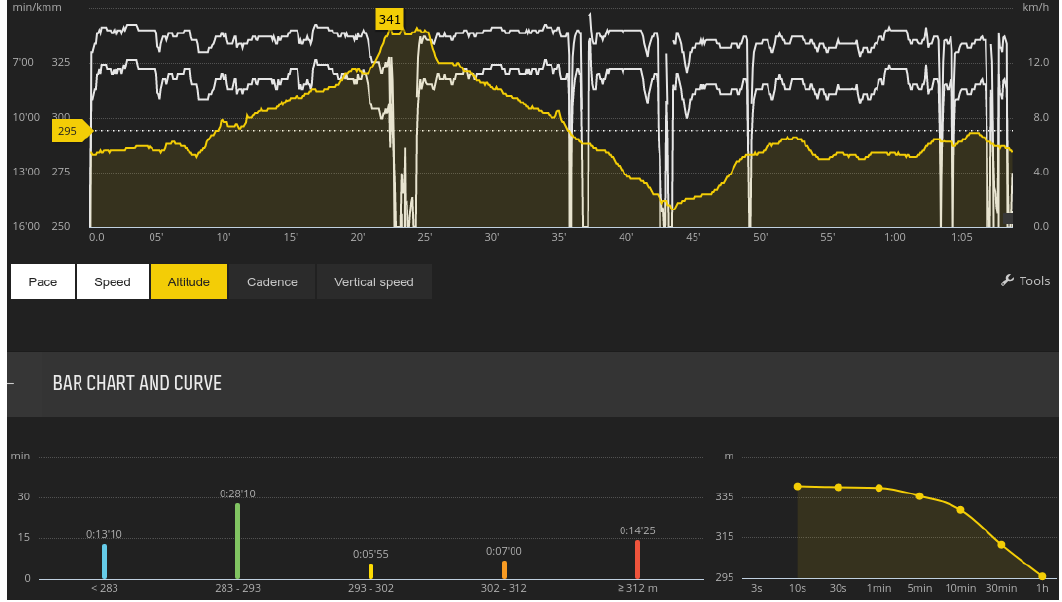
Figure 4. Visualization of running activity on the Movescount